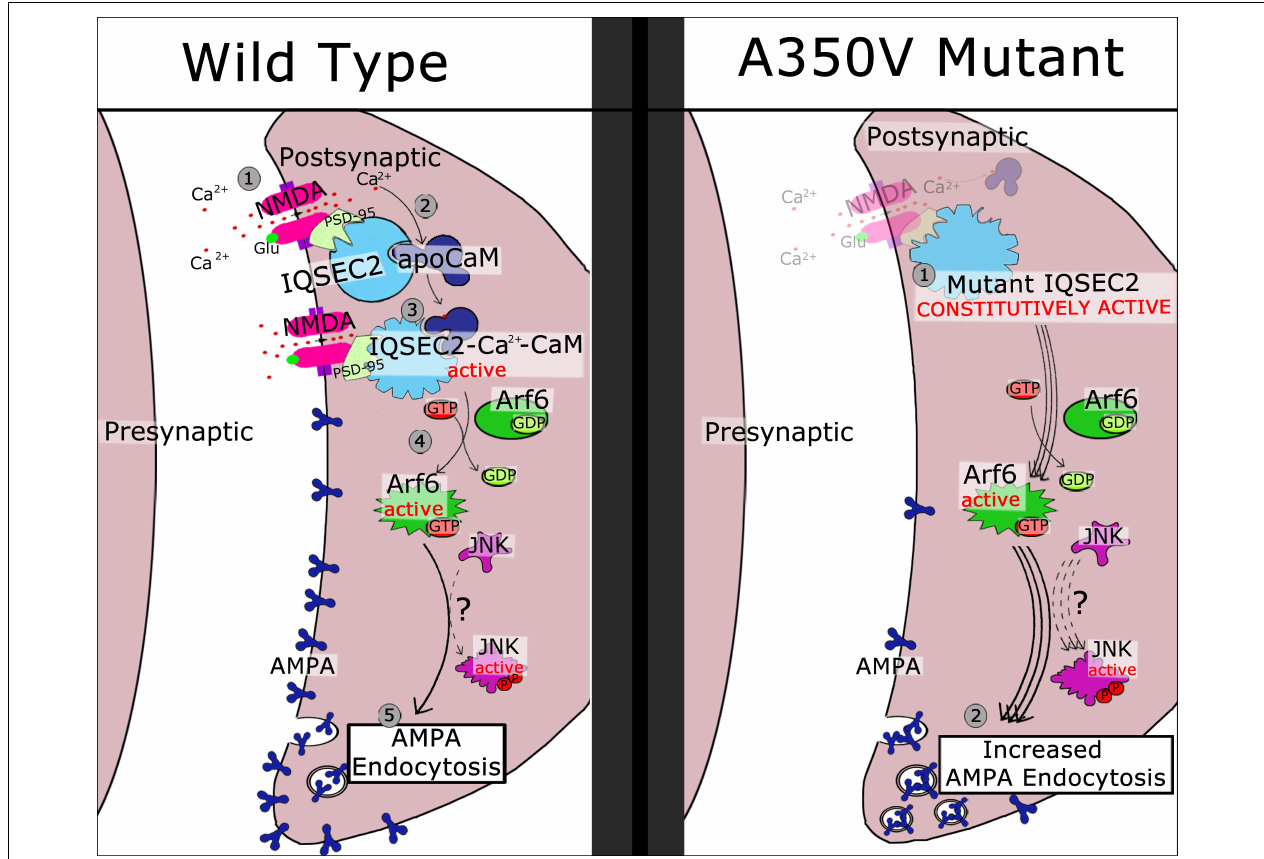
FIGURE 10 | Schematic model of regulatory cascade mediated by wild type and A350V IQSEC2 mutant and consequences for AMPA trafficking. Wild type IQSEC2. (1) Activation of NMDA receptor with calcium influx. (2) Calcium can bind to apocalmodulin which is already bound to IQSEC2. (3) Ca-calmodulin bound to IQSEC2 induces a conformational change in IQSEC2 that leads to activation of IQSEC2 GEF activity (4) resulting in formation of active Arf6-GTP. Arf6-GTP promotes endocytosis of surface AMPA receptors (5) by pathways that are poorly understood, but which may include JNK (Myers et al., 2012). A350V mutant IQSEC2. (1) A350V IQSEC2 has conformation similar to active form of wild type IQSEC2 and has constitutive GEF activity capable of promoting increased Arf6-GTP formation (2). Increased Arf6-GTP results in more pronounced down regulation of surface AMPA receptors (3).